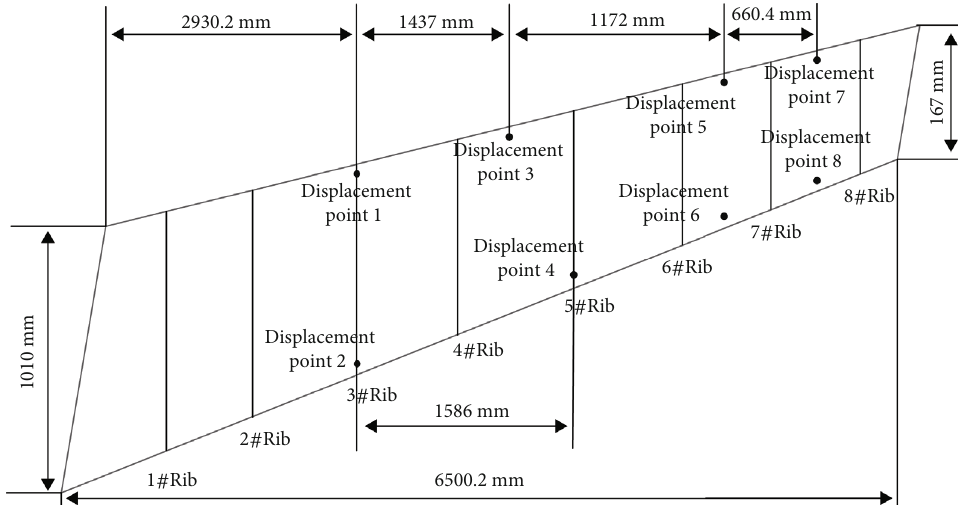
Figure 13: Schematic diagram of wing size.